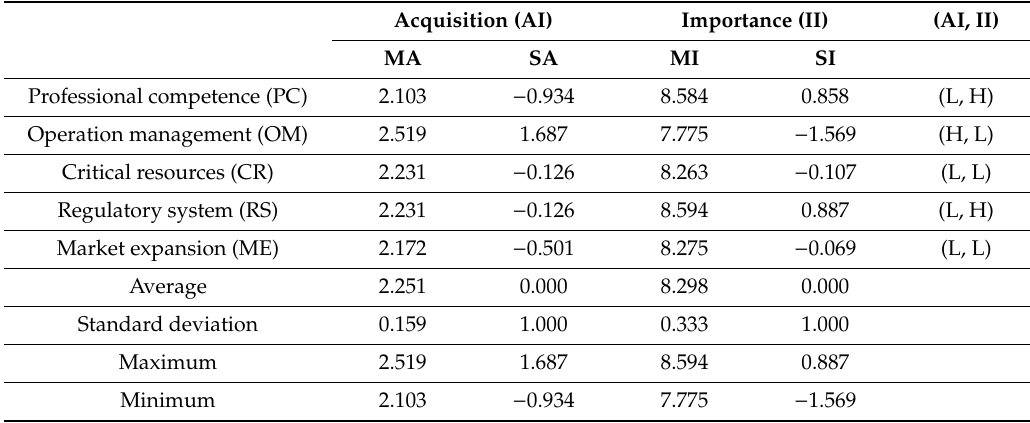
Table 3. The AIA analysis of digital transformation.